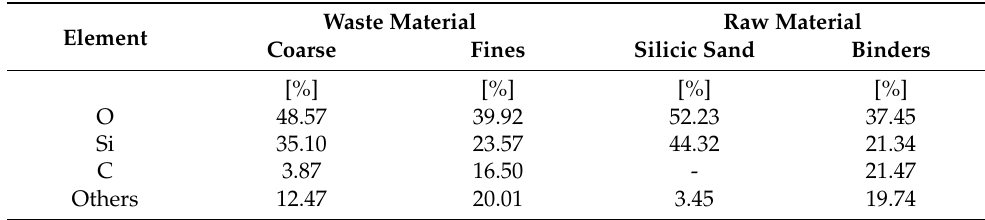
Table 2. Partial result of ICP of the waste material (coarse waste material is the used in this study) and the raw material for foundry